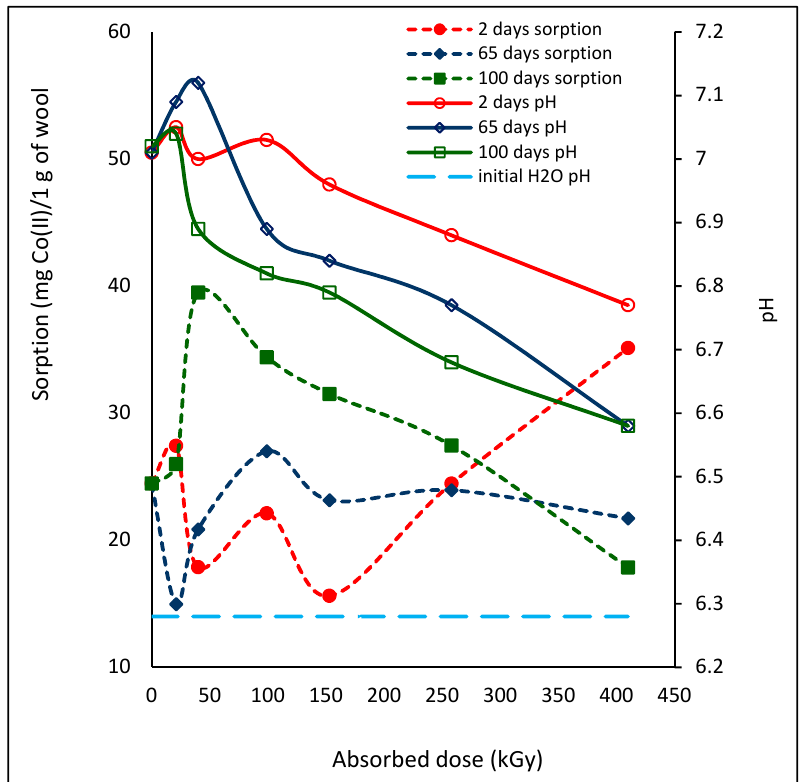
Figure 10. Variation of Co(II) sorption (for c = 125 mmol·dm − 3 ) and pH of aqueous extracts from wool with different time lapse from the irradiation depending on absorbed dose.